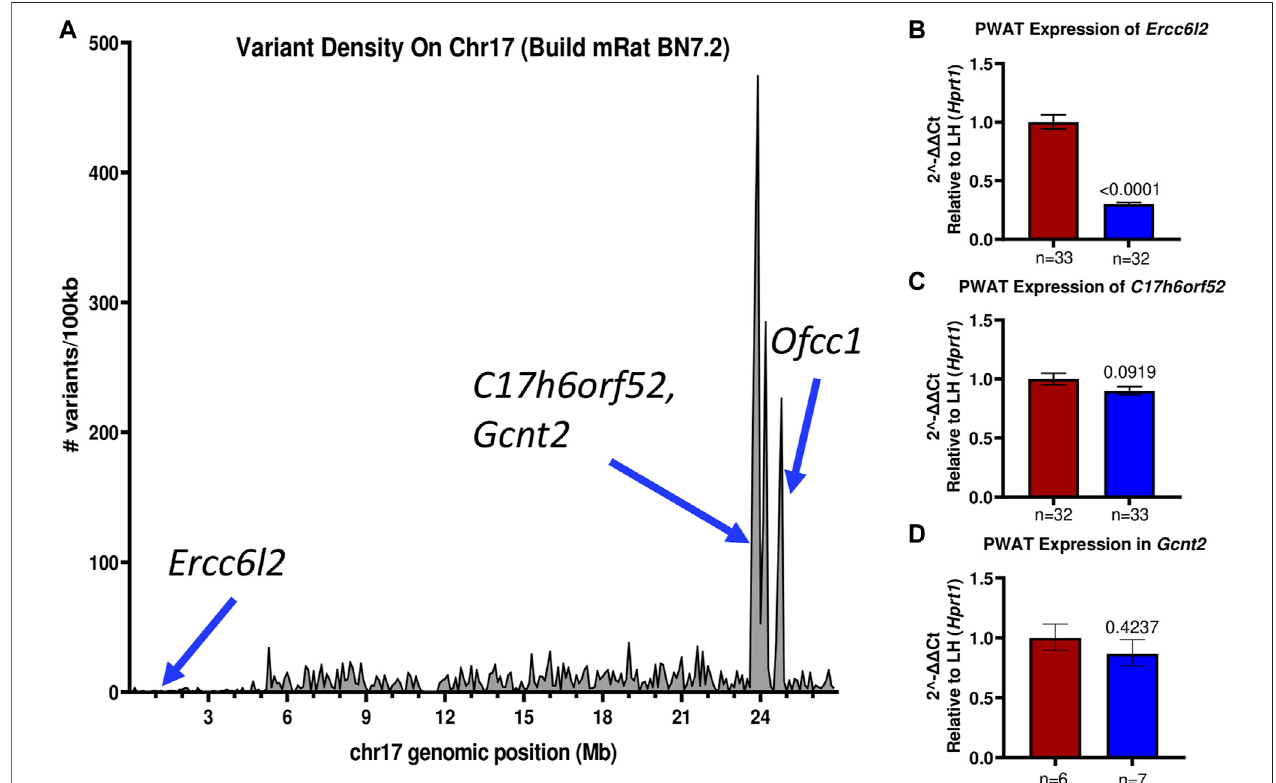
FIGURE 5 | The LH 17 LNa congenic interval contains several possible candidate genes. (A) The LH and LN rat genomes were sequenced and aligned to mRatBN7.2. Total genomic variants unique to either the LH or LN strains were divided into 100 kilobase (100 kb) intervals and plotted to visualize the major LH/LN haplotypes. (B – D) Expression of potential candidate genes (B) Ercc6l2 , (C) C17h6orf52, and (D) Gcnt2 were analyzed in female PWAT tissues, using Hprt1 as an endogenous control. (B) Ercc6l2 is signi fi cantly downregulated (~70%) in LH 17 LNa congenic females relative to the control LHs (LH: n = 33; LH17LNa: n = 32; p <